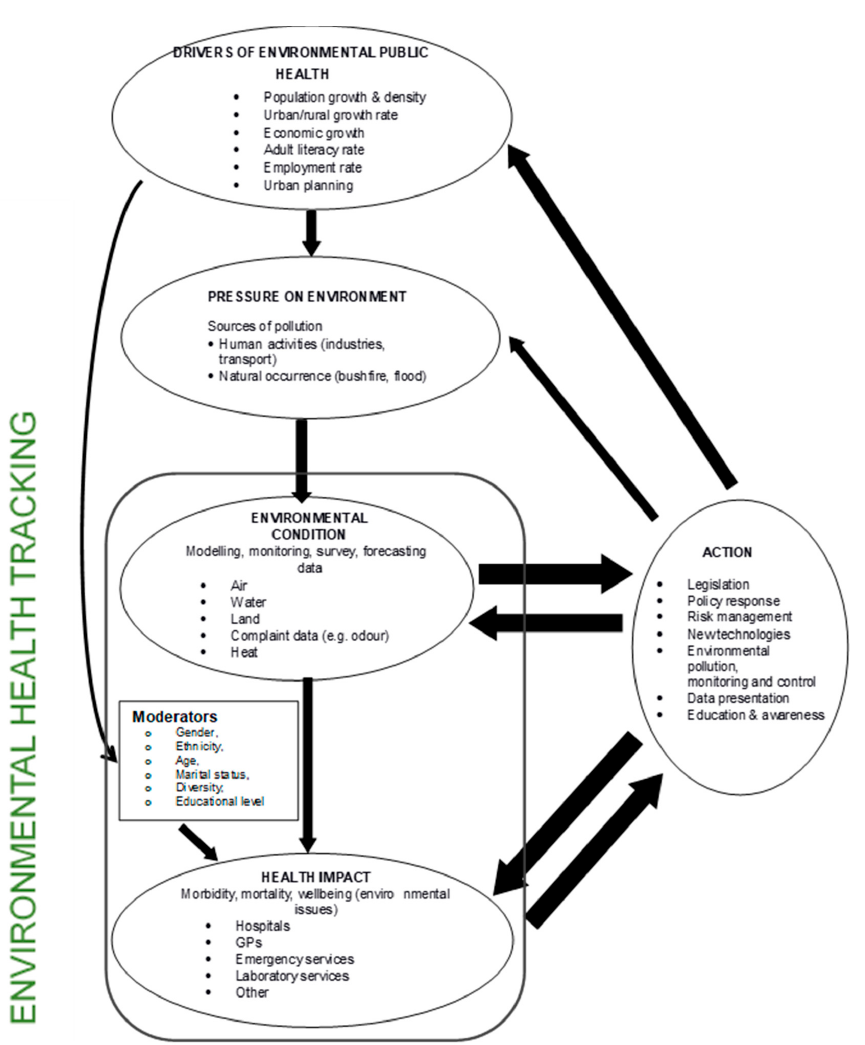
Figure 1. Proposed conceptual framework for EPA’s environmental health tracking.